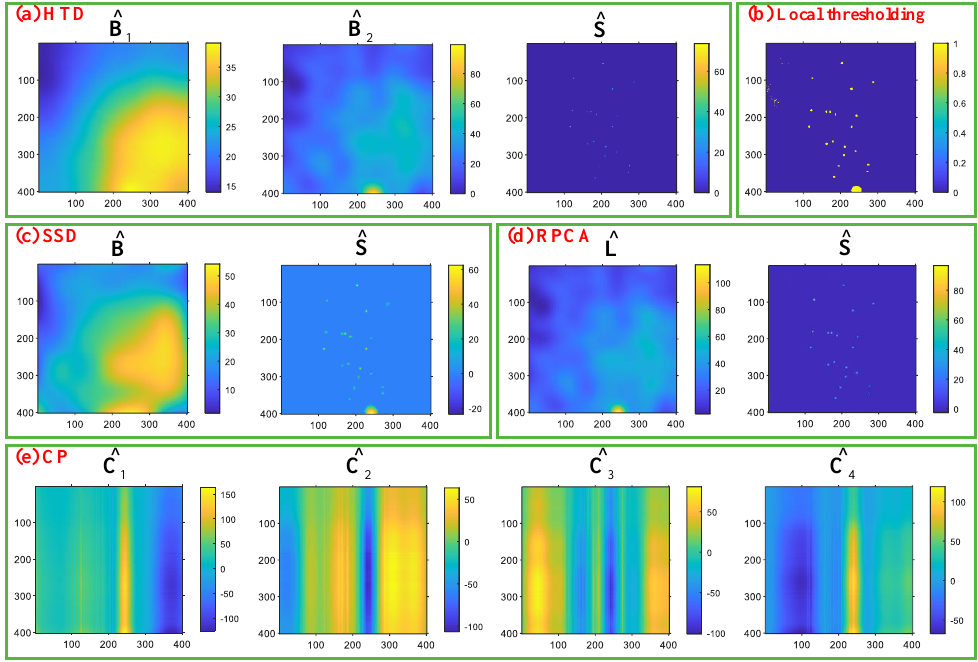
Figure 5. Results of the simulation data using the proposed method and benchmark